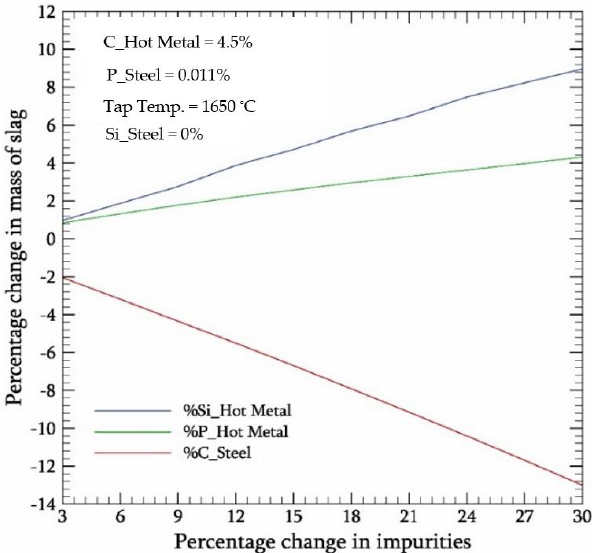
Figure 3. Sensitivity of impurities on mass of slag required for the process.